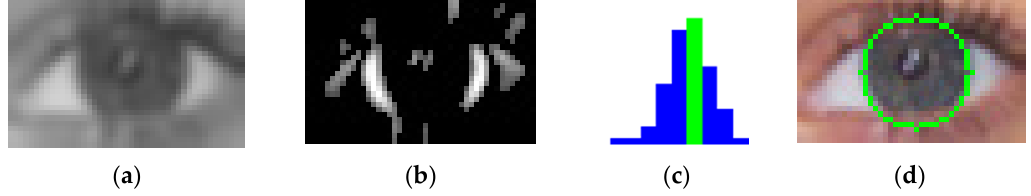
Figure 5. Iris radius computation. ( a ) Blurred eye region; ( b ) Vertical Sobel derivative (with k = 20% of the gradients ignored); ( c ) Radial projection of the image (the selected radius is depicted in green); and ( d ) the iris radius.